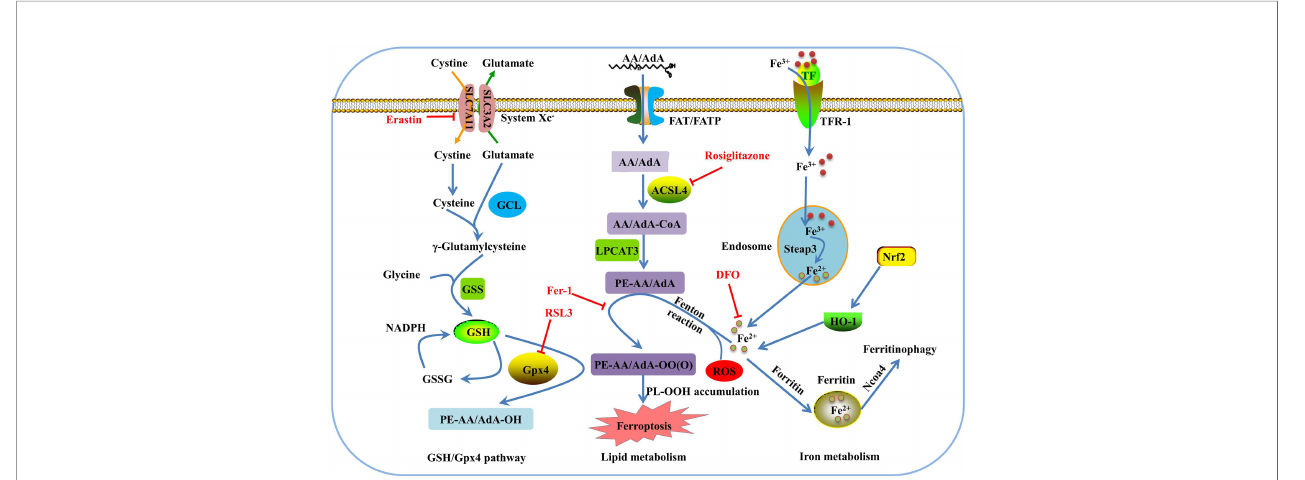
FIGURE 1 | Overview of the ferroptosis pathway. GSH is synthesized from glutamate, cysteine, and glycine, and catalyzed by glutamate cysteine ligase (GCL) and glutathione synthetase (GSS). GPX4 converts GSH to glutathione oxidized (GSSG) to inhibit lipid ROS production. Erasin and RSL3 trigger ferroptosis by inhibiting of system Xc- and Gpx4. In lipid metabolism pathway, phosphatidylethanolamine-adrenic acid/arachidonic acid (PE-AA/AdA) is synthesized in two steps catalyzed by Acyl-CoA synthetase long-chain family member 4 (ACSL4) and lysophosphatidylcholine acyltransferase 3 (LPCAT3). Rosiglitazone is the strongest inhibitor of ACSL4 that alleviates ferroptosis. Transferrin receptor 1 (TFR-1), transferrin (TF), ferritin, and Ncoa4 are involved in iron metabolism and are closely associated with ferroptosis. Deferoxamine (DFO) and ferrostatin-1(Fer-1) inhibit ferroptosis by regulating iron level and lipid oxidation,